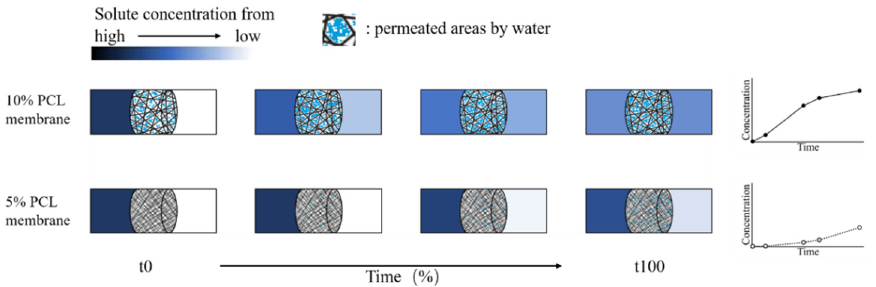
Figure 9. A demonstration of the release mechanisms proposed for the different release profiles for the 5% and 10% PCL